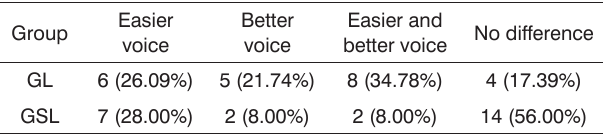
Table 1. Voice self-assessment after SOVTE - phonation into a straw